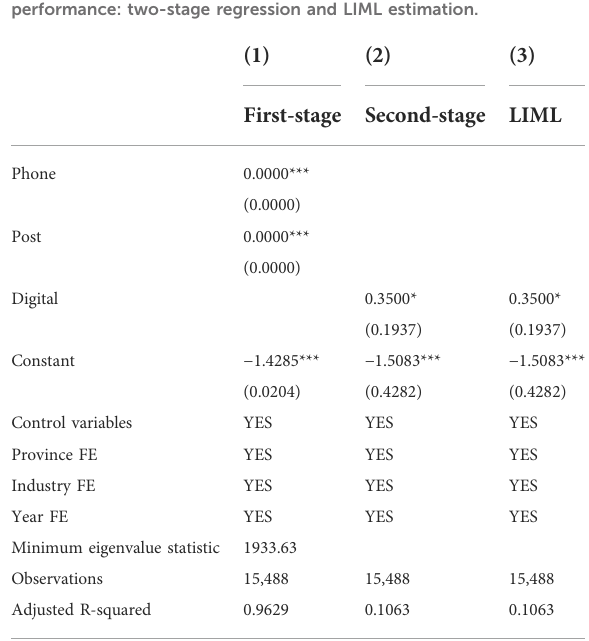
TABLE 8 Impact of digital economy development on ESG performance: two-stage regression and LIML